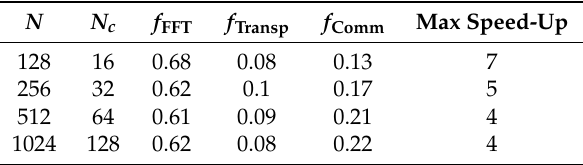
Table 1. Fraction of total runtime for each of the main operations involved in the distributed transform: FFTs ( f FFT ), transpose ( f Transp ), and communications ( f Comm ), for runs done with different linear resolutions N and number of cores N c . The remainder of the time in each run is spent on other computations. The last column gives the maximum speed-up possible if the cost for the local FFTs and transposes are driven to